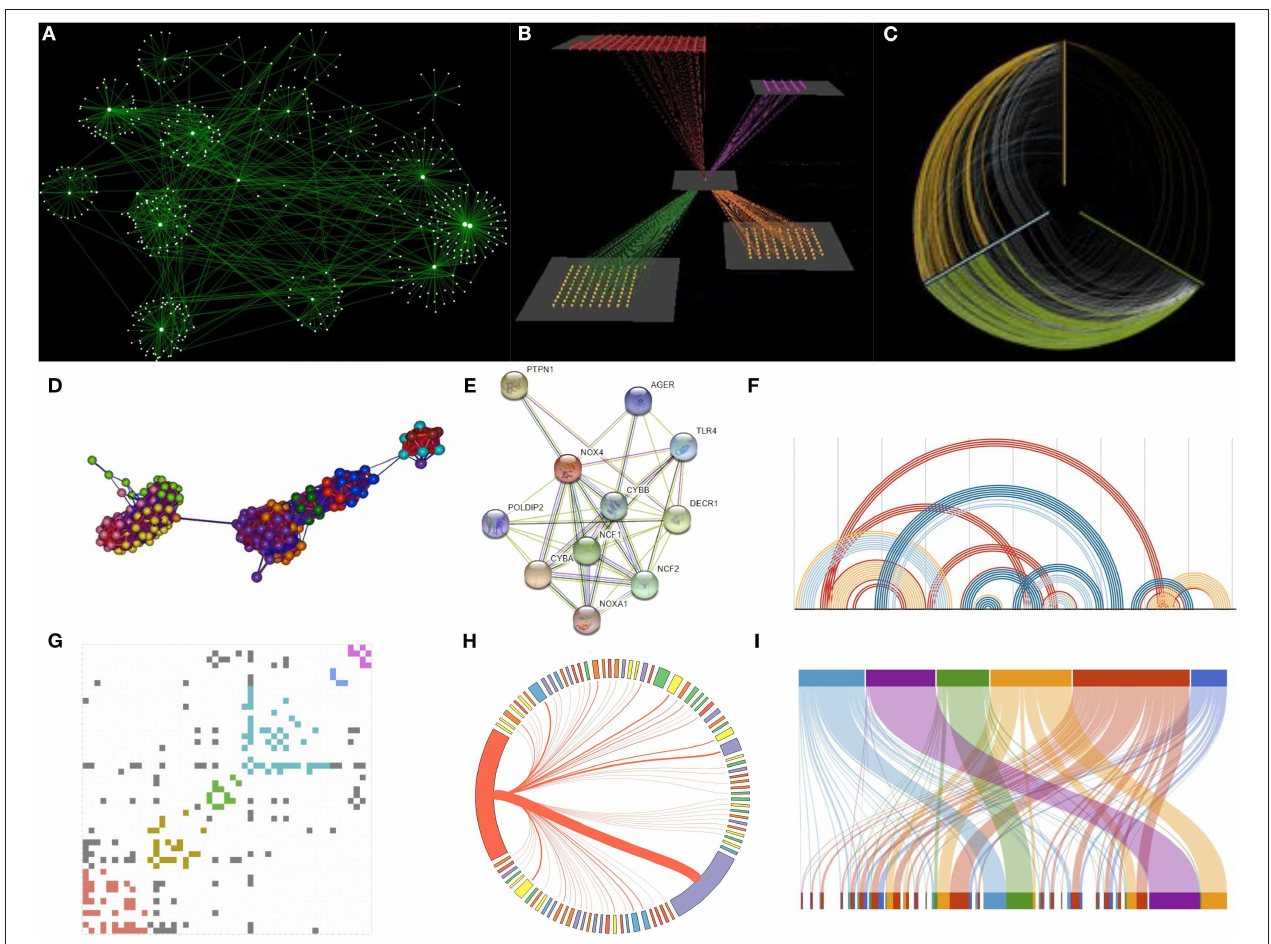
FIGURE 9 | Network representations. (A) A network visualized by Cytoscape with the use of a force-directed layout algorithm. (B) A multi-layered graph visualized by Arena3D. (C) A hive-plot view. (D) A network in 3D visualized by Graphia application (E) A multi-edge network visualized by STRING. (F) A network visualized with the use of arcs. (G) A network visualized as a colored adjacency matrix. (H) A circular Circos view. (I) Visualization of a bipartite